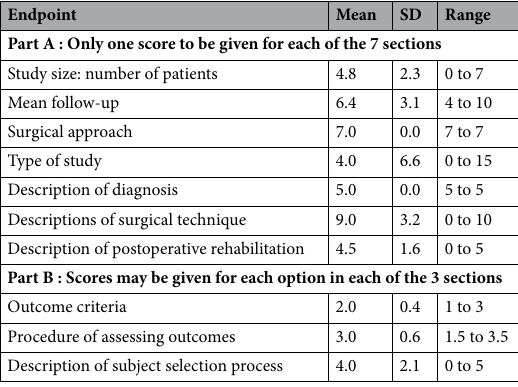
Table 1. Coleman methodology score.